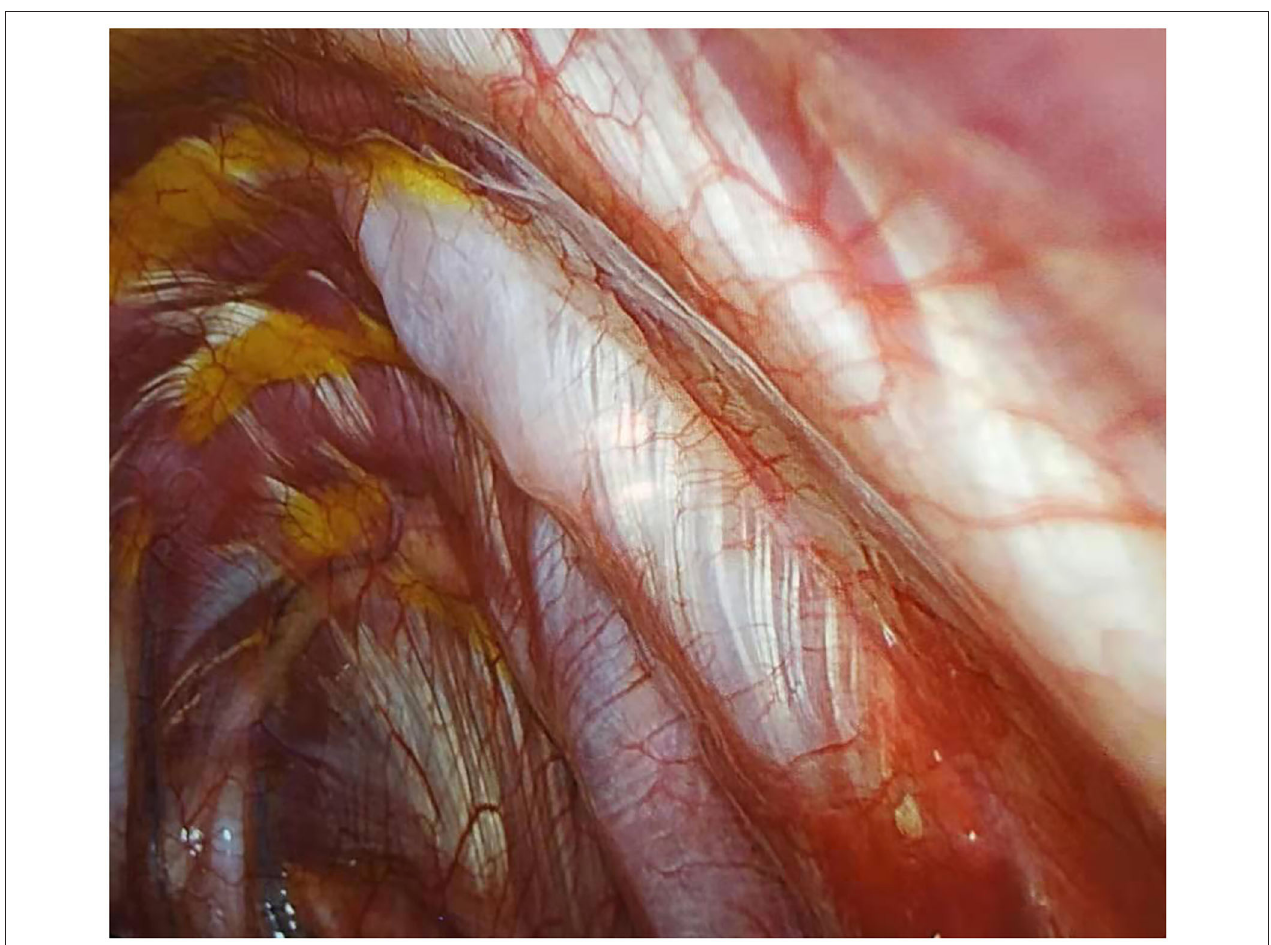
FIGURE 2 | Infiltration of local anesthetic mixture (15ml for each intercostal space) through thoracoscopic intercostal nerve block